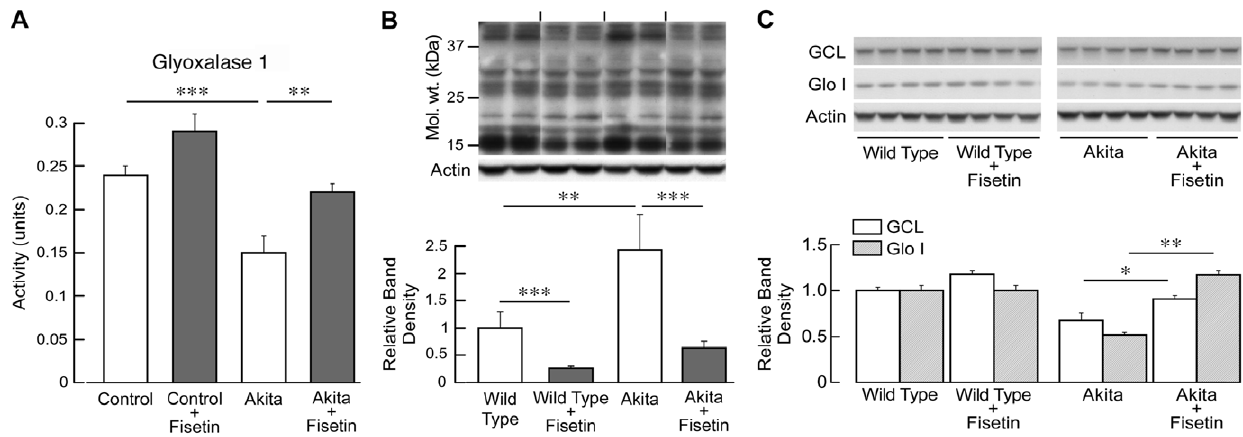
Figure 6. Fisetin reduces MG-dependent protein glycation in the cortex. Brain cortical extracts were prepared and analyzed exactly as for the kidney shown in Fig. 5 with 6 to 8 animals per group. (A) Glyoxylase 1 enzymatic activity. (B) Protein analyzed by SDS-PAGE and Western blotting with an antibody to MG with actin as a loading control. The entire gel as shown was scanned and the total density normalized to actin. (C) Western blotting with anti-GCL and Glo-1 antibodies. In B and C, the data are presented graphically as relative band density of indicated protein over actin. ***( p , 0.001), **( p , 0.01) and *( p , 0.05) indicate significantly different from wild type or Akita alone as determined by ANOVA followed by Tukey’s post test.